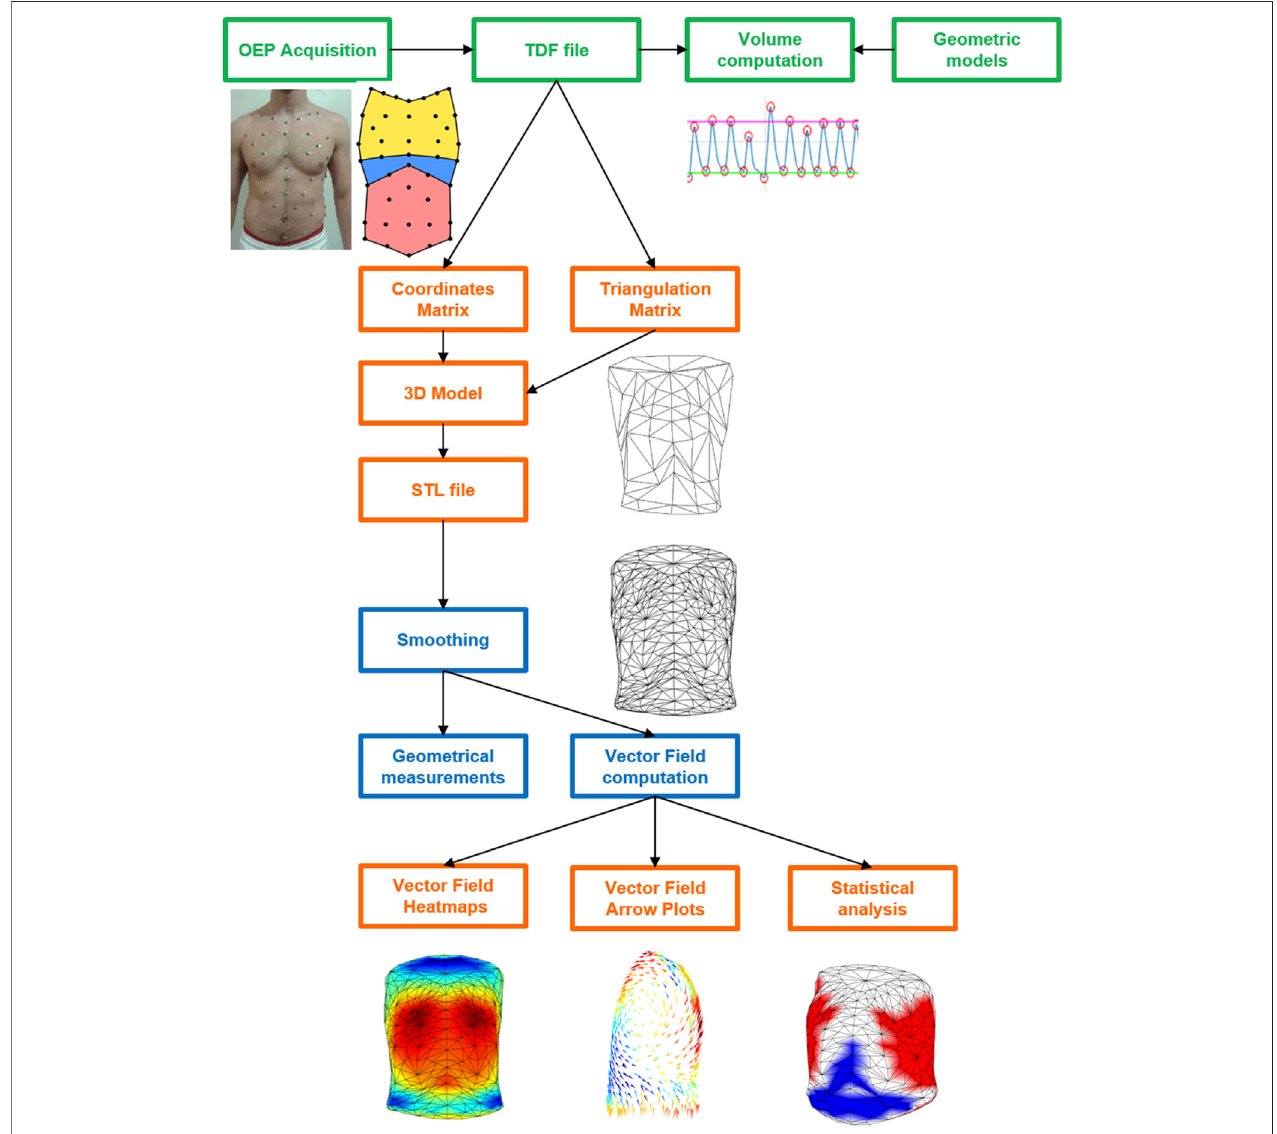
FIGURE3| Schematicdiagramofthewholeprocessfrom3Dmarkers ’ coordinatesto3DheatmapandVFplotstartingfromOEPacquisition(green),passingfrom theelaborationofthecoordinates(TDF fi le)andtriangulationmatrixesinMATLAB(orange)tocreatethe3DmodelsintheSTL fi lethatwasthenelaboratedin3dsMaxfor the smoothing and the computation of the geometrical parameters and of the vector fi eld (blue) The latter was plotted as colormaps and arrow plot as well as in terms of statistical results in MATLAB (orange).